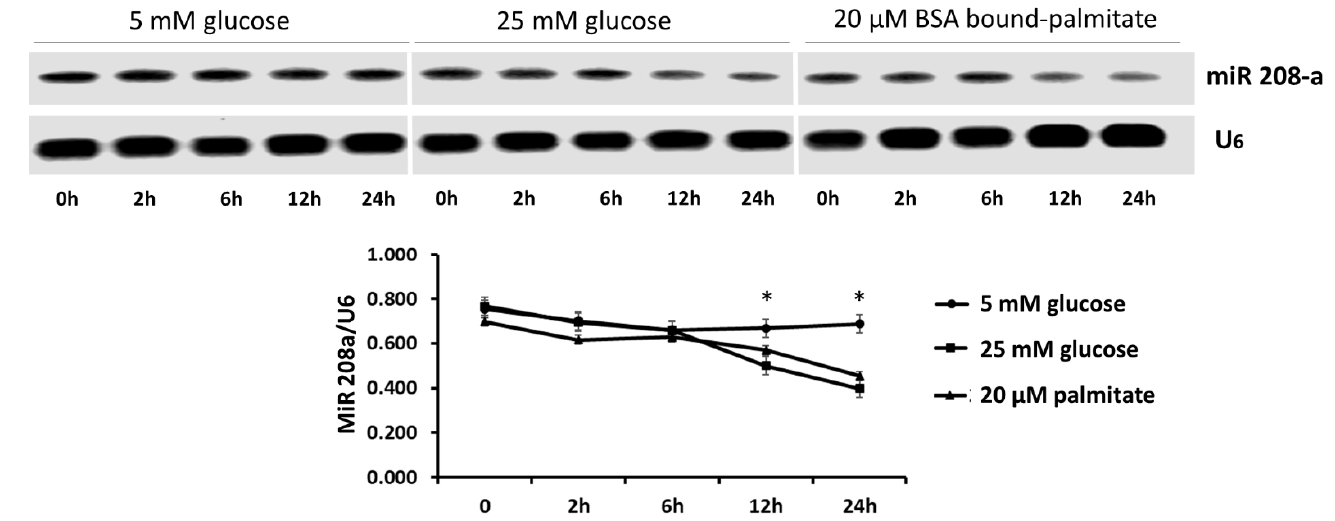
Figure 1. MicroRNA 208a in human cardiomyocytes exposed to metabolic stress. SV40 human cardiomyocytes were incubated with 5 mM glucose, 25 mM glucose or 20 mM bovine serum albumin (BSA)-bound palmitate for 0 to 24 h. The results are expressed as the mean ± SEM of three independent experiments. * p < 0.05 when comparing 5 mM glucose with either 25 mM glucose or 20 µM palmitate.